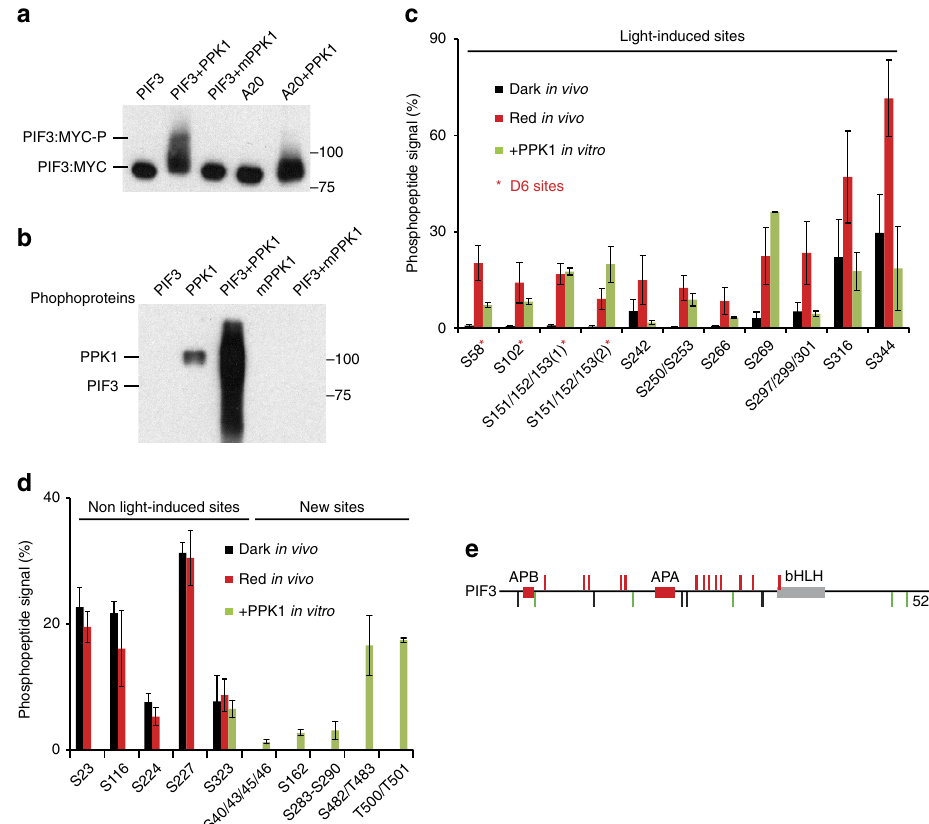
Figure 4 | PPK1 phosphorylates PIF3 at light-inducible phosphosites in vitro. ( a ) PPK1 induces a strong mobility shift in PIF3 in an in vitro kinase assay. PPK1 and MYC-tagged PIF3 variants, affinity-purified after expression in E. coli , were combined under protein-kinase-assay conditions and examined for an induced, potentially phosphorylation-related, mobility-shift in PIF3 by immunoblot blot analysis using anti-MYC antibody. mPPK1: kinase-dead mutant of PPK1; A20: phospho-dead mutant of PIF3 mutated in the 20 phosphoresidues induced by light in vivo . ( b ) PPK1 phosphorylates PIF3 in vitro . Phosphoproteins from the indicated in vitro protein-kinase-assay combinations were detected by western blot using pIMAGO-biotin. ( c , d ) Mass- spectrometric analysis of in vitro , PPK1-catalysed phosphosites in PIF3 compared to those sites established as rapidly induced ( c ), or unaffected ( d ), by red light (Rp) in vivo . d (left), constitutively phosphorylated, non-light-induced in vivo , (right) not detectably phosphorylated in dark or light in vivo , PPK1-induced in vitro . Phosphopeptide Signal (%) corresponds to the percent of the residues at each site that are phosphorylated in Dk-grown or Rp-treated seedlings, or in PPK1-treated PIF3 in vitro . D6, strongly light-induced sites in vivo . Data are the means of biological repeats ± s.e. ( e ) Schematic depiction of PIF3 phosphosites. Red bars represent phosphosites that are both light-induced in vivo and catalysed by PPK1 in vitro . Black bars represent sites that are constitutively phosphorylated in vivo , but not detectably phosphorylated by PPK1 in vitro , except S323. Green bars represent newly identified phosphosites catalysed by PPK1 in vitro . APB, active phyB-binding domain; APA, active phyA-binding domain; bHLH, basic helix-loop-helix